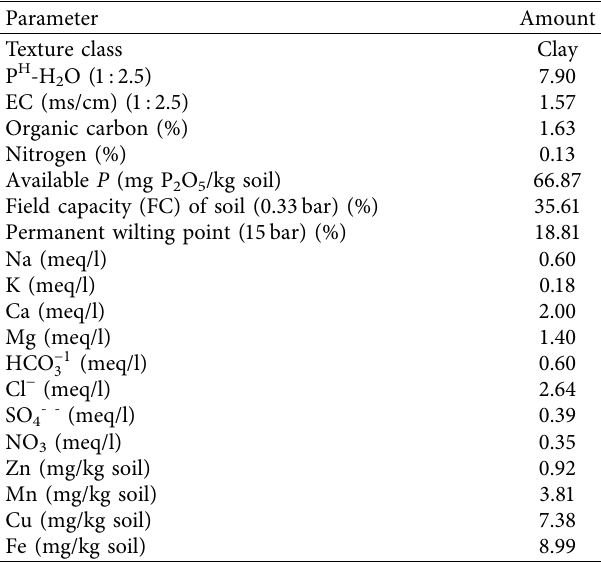
Table 2: Physicochemical analysis of the experimental soil in Ezo- Otte in the Chencha district of Gamo highlands in southern Ethiopia in main cropping season,